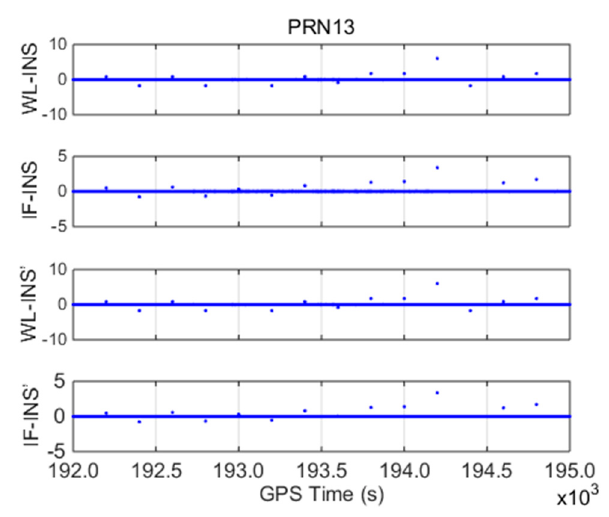
Figure 5. Cycle slip detection models for PRN13 with simulated cycle slips (unit: meter).